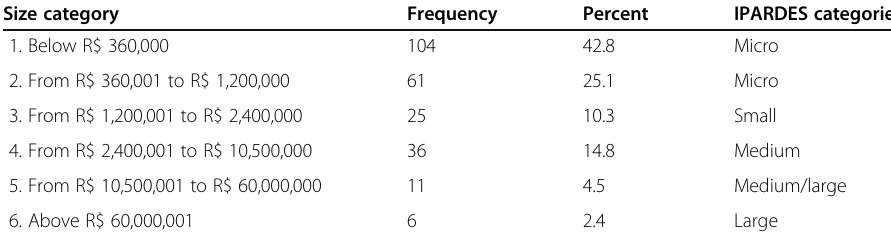
Table 1 Size categories of companies in the sample Size category